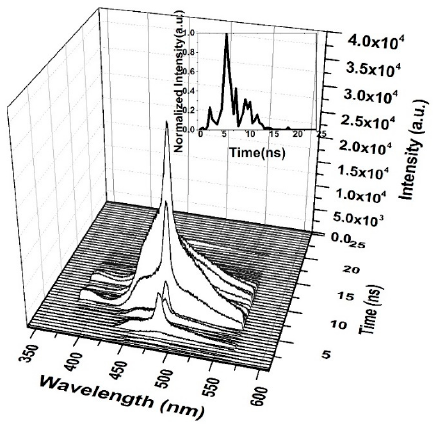
Figure 14. Time dynamics of CO in chloroform at pump energy of 3 mJ and a concentration of 15 mg/mL. The subfigure is the Z slice at 482 nm, which gives the intensity (a.u) vs time (ns) profile of the ASE peak at 482.5 nm.